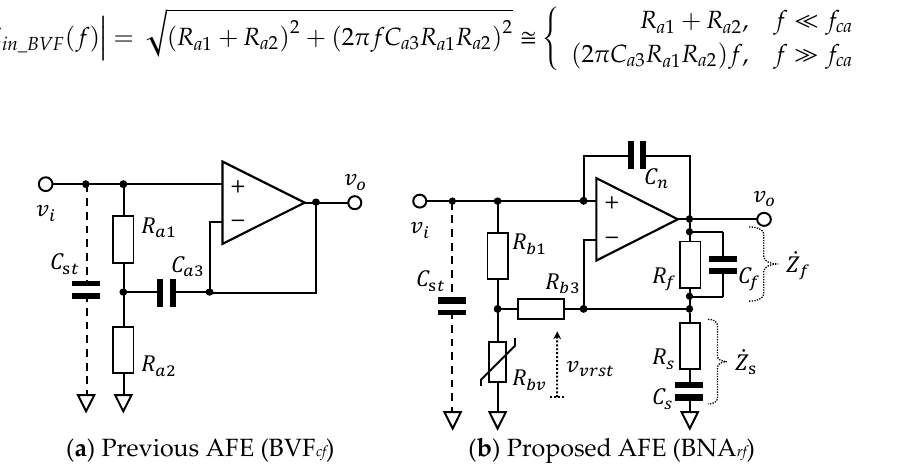
Figure 1. Configuration of analogue front ends (AFEs) involving bootstrapping techniques: ( a ) Previous AFE (BVF cf ) bootstrapped by resistors R a 1 and R a 2 , and a feedback capacitor C a 3 . This serves as a voltage follower; ( b ) Proposed AFE (BNA rf ) bootstrapped by resistors R b 1 and R b 3 , and a varistor with voltage-dependent resistance R bv . This serves as a non-inverting bandpass amplifier by the use of resistors R s and R f , and capacitors C s and C f . A capacitor C n is incorporated to reduce stray capacitance C st .